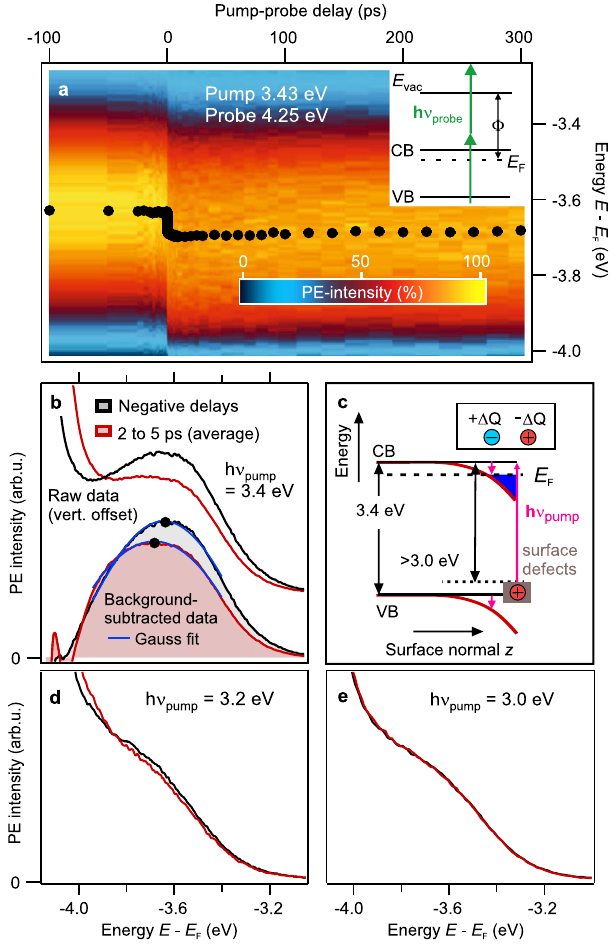
Fig. 3 Downward shift of the VB upon resonant and below band gap excitation. a PE intensity from the VB in false colors as a function of pump- probe delay probed with h ν probe = 4.25 eV. This photon energy is below the work function of the sample ( Φ = 4.4 eV) and the VB is accessed by two- photon photoemission, see the energy sketch in the inset. The pump photon energy is 3.43 eV at a fl uence of 27 μ J/cm 2 . Markers: peak positions, determination see b . b Comparison of VB spectra at negative delays (black) and at positive delays (red). Top: Raw data (vertically offset for clarity). Bottom: Data after subtracting the background of secondary electrons. Blue: Gaussian fi ts to determine the peak maximum. c Energy level diagram with a sketch of downward surface BB along the surface normal z . d , e VB spectra at negative (black) and positive delays (red) for different pump photon energies below the fundamental negative delays (black) to one at a positive pump-probe delay of few ps (red). Clearly, the VB is transiently shifted to lower energies. The false color plot in Fig. 3a shows that the downward shift occurs abruptly and persists for several hundred ps. Based